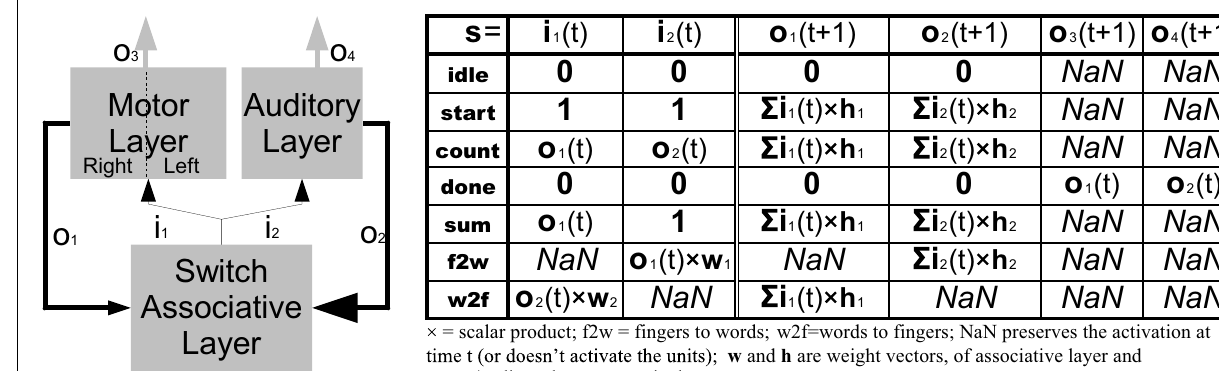
FIGURE 3 | Details of the Switch/Associative Layer. The table on the right summarizes the outputs according to the different states. In practice the layer operates as a recursive feedback with the possibility to start and reset the motor/auditory layers and to derive the